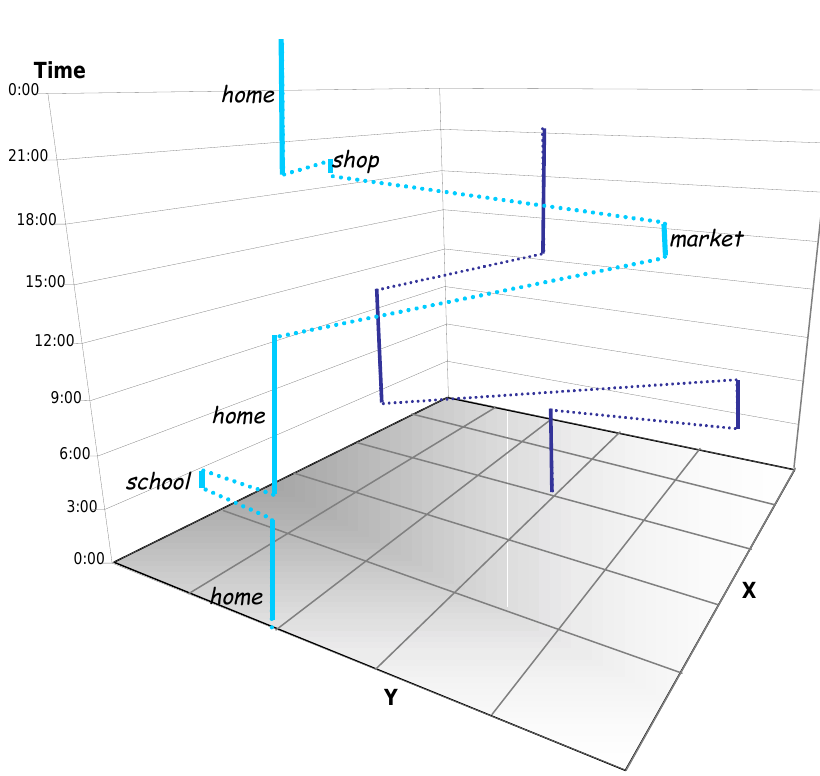
Figure 1. An Indicative Daily Movement Trajectory for two VATS respondents